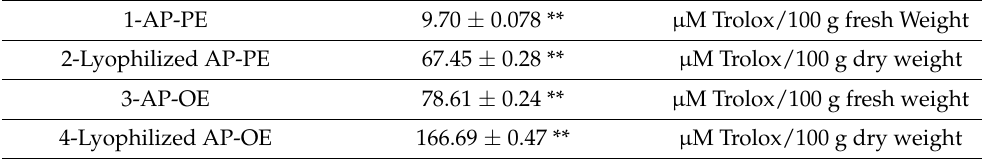
Table 3. Antioxidant activity of apple pomace extracts before and after lyophilization. 1-AP-PE 9.70 ± 0.078 ** µ M Trolox/100 g fresh Weight 2-Lyophilized AP-PE 67.45 ± 0.28 ** µ M Trolox/100 g dry weight 3-AP-OE 78.61 ± 0.24 ** µ M Trolox/100 g fresh weight 4-Lyophilized AP-OE 166.69 ± 0.47 ** µ M Trolox/100 g dry